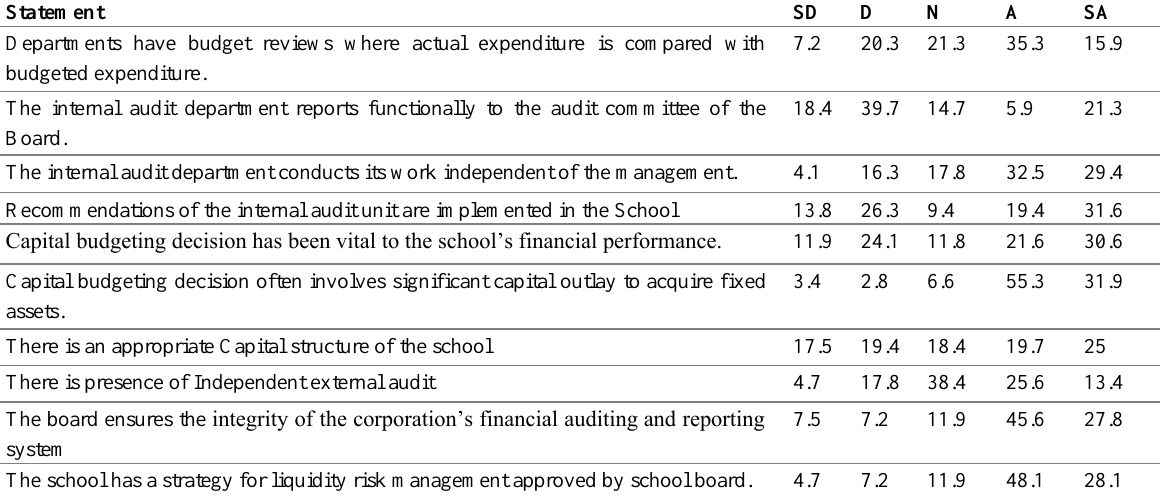
Table 2: Descriptive Statistics on Financial Control